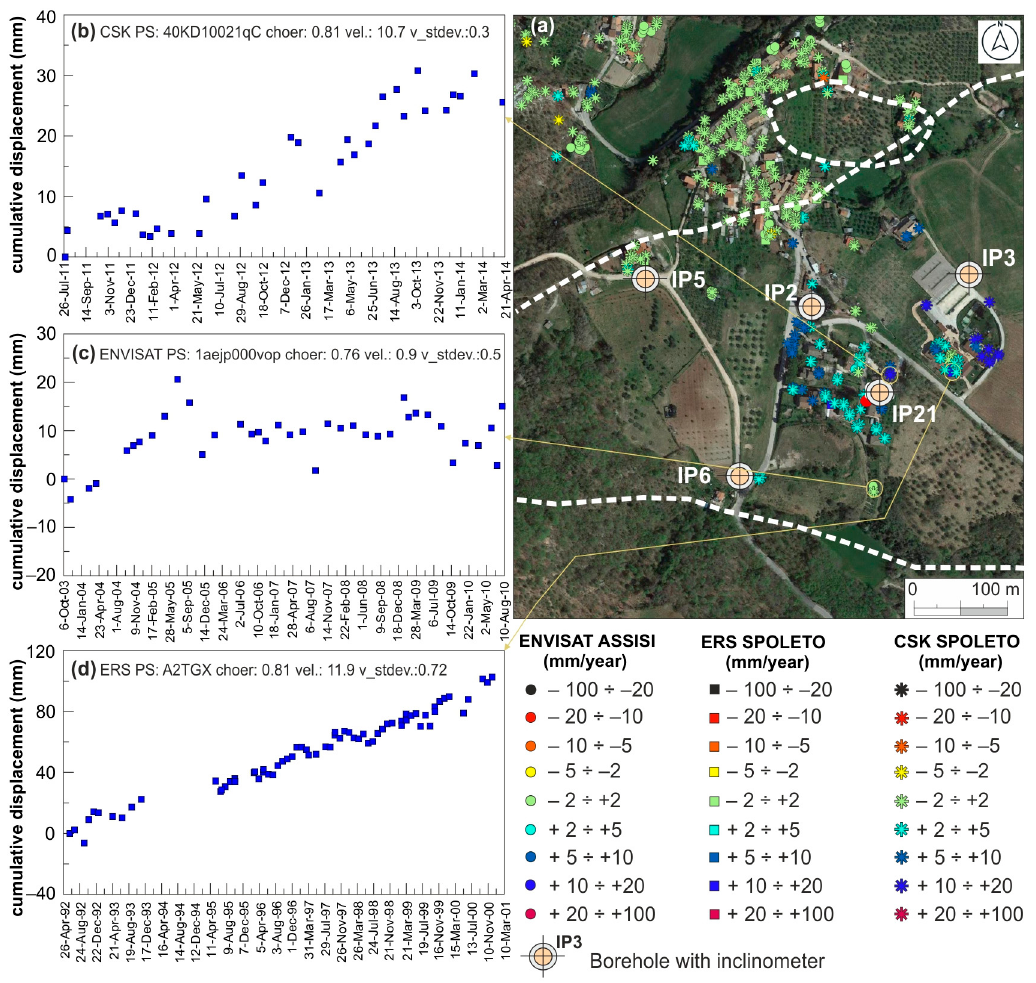
Figure 7. Cumulative displacement extracted from three PS points. ( a ) Location of PS; ( b ) cumulative displacement of CSK PS: 40KD10021qC; ( c ) cumulative displacement of ENVISAT PS: 1aejp000vop; ( d ) cumulative displacement of ERS PS: A2TGX. Data are in Table S1.